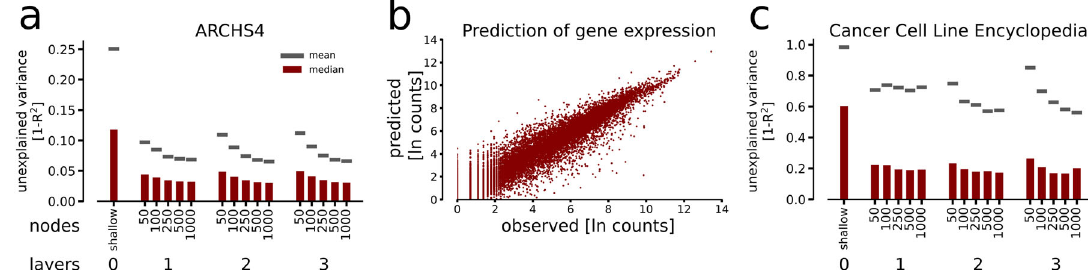
Fig. 2 Gene expression prediction performance. a We applied the DNNs and the shallow model to previously unseen gene expression pro fi les randomly selected from the ARCHS4 database, and calculated the coef fi cient of determination, R 2 , for each gene. Shown are the median (red bar) and mean (gray line) of the R 2 values for each model. b The typical prediction of an experiment is shown for the DNN with two hidden layers and 250 hidden nodes in each layer. c We applied the DNNs to predict gene expression values from 934 human tumor samples from the Cancer Cell Line Encyclopedia. Shown are the abilities to predict this data set for the respective models, following the same layout as in a